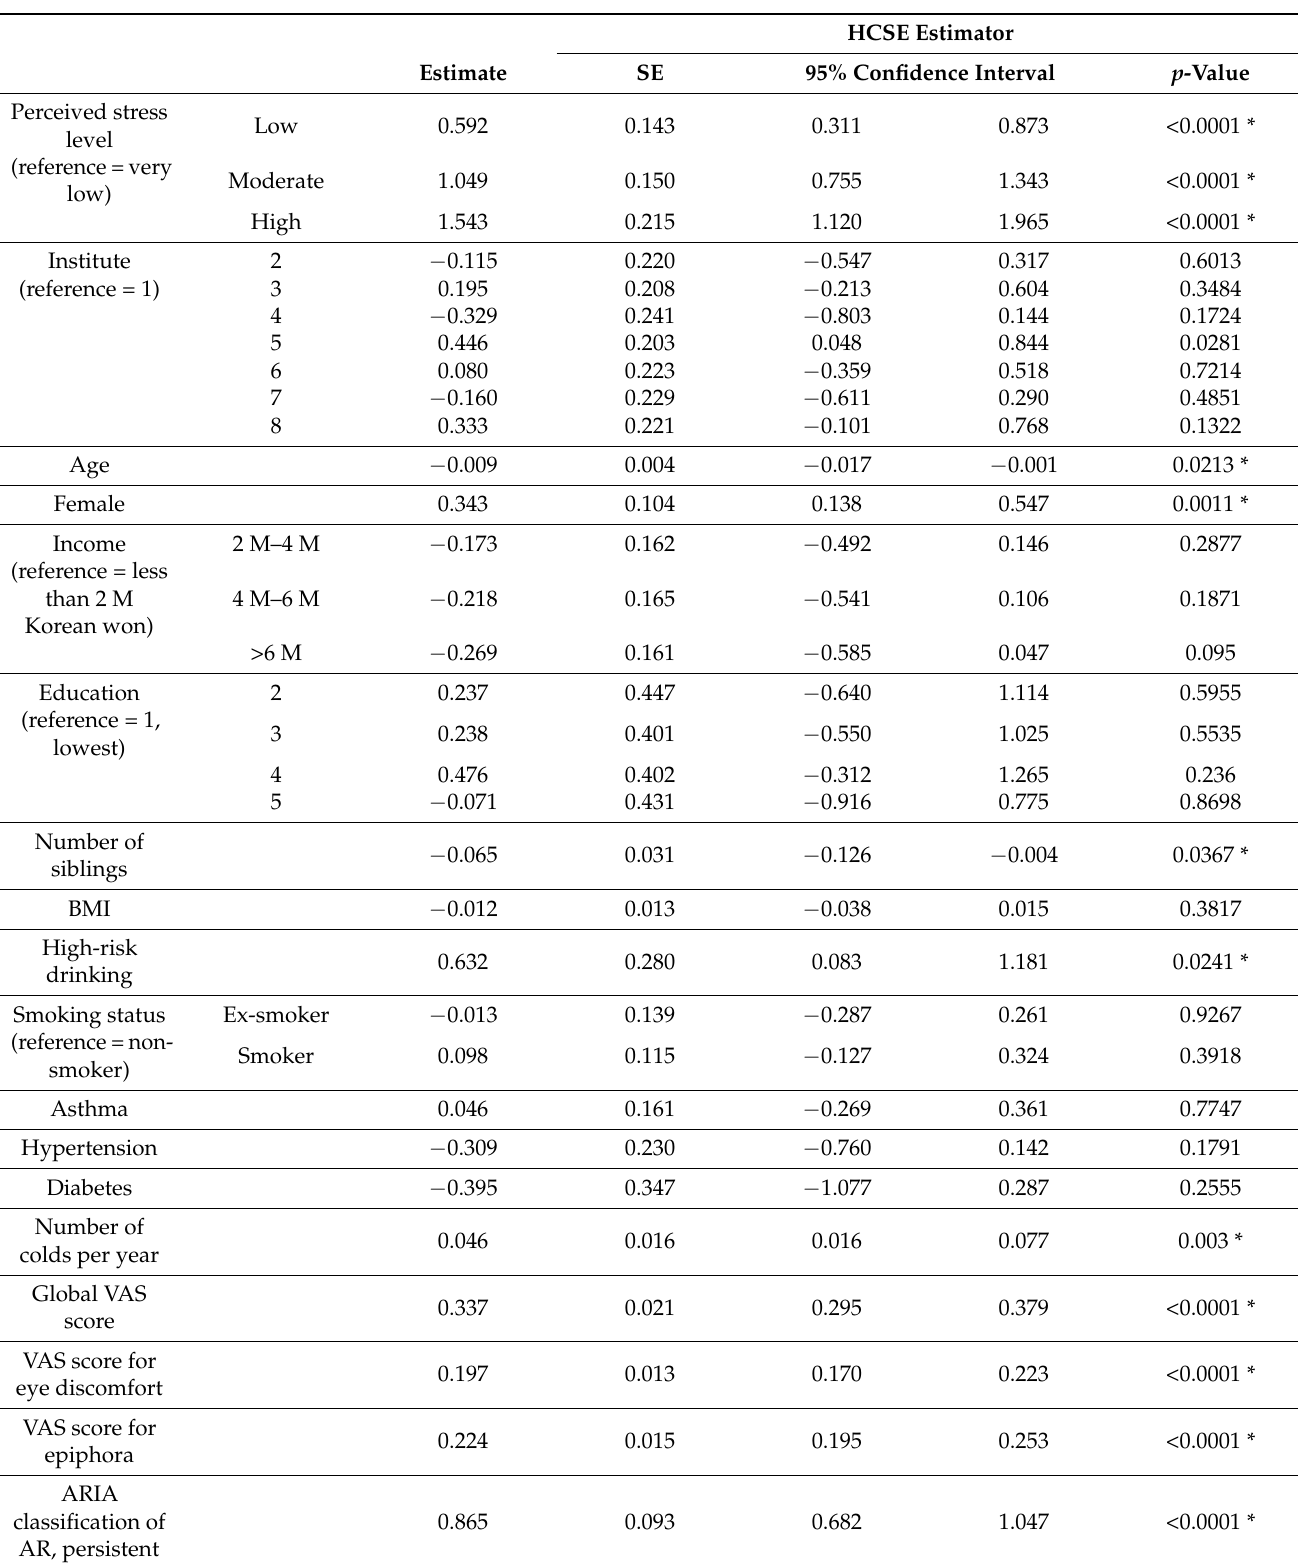
Table 2. Univariable regressions of the variables of the patients with AR for disease-related quality of life score (RQLQ